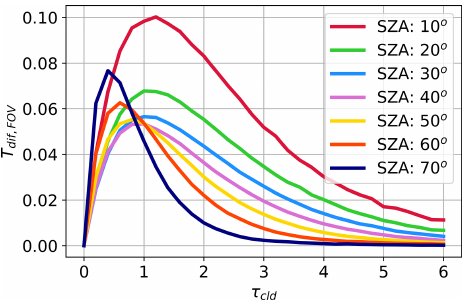
Figure A2. T dif,FOV as a function of τ cld for the 500nm wave- length. The relationship is shown for multiple SZAs ranging from 10–70 ◦ .